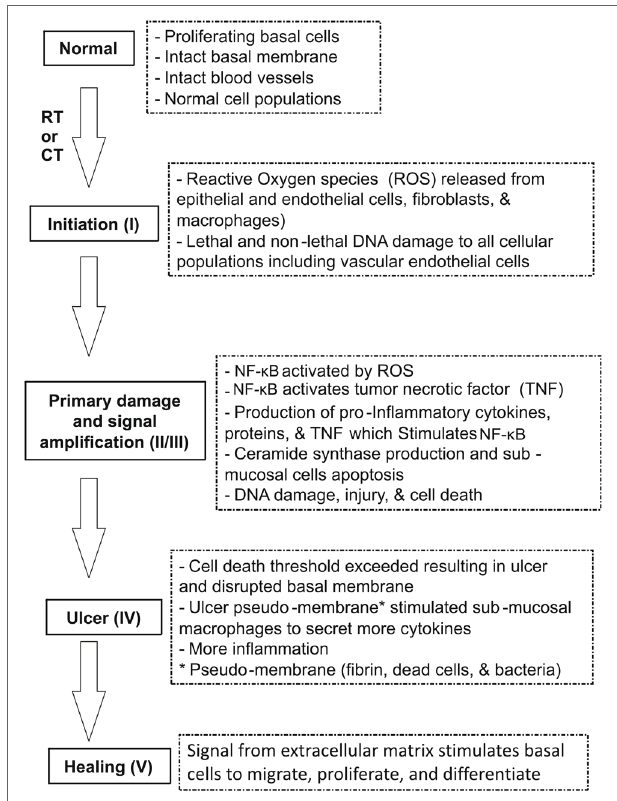
FiGuRe 1 | Pathobiology of oral mucositis (OM) (10) . Sonis has suggested five stages (phases) of OM injury induced by radiotherapy (RT) and/or chemotherapy (CT): initiation, signaling, amplification, ulceration, and healing. The pathogenesis of each phase is illustrated.